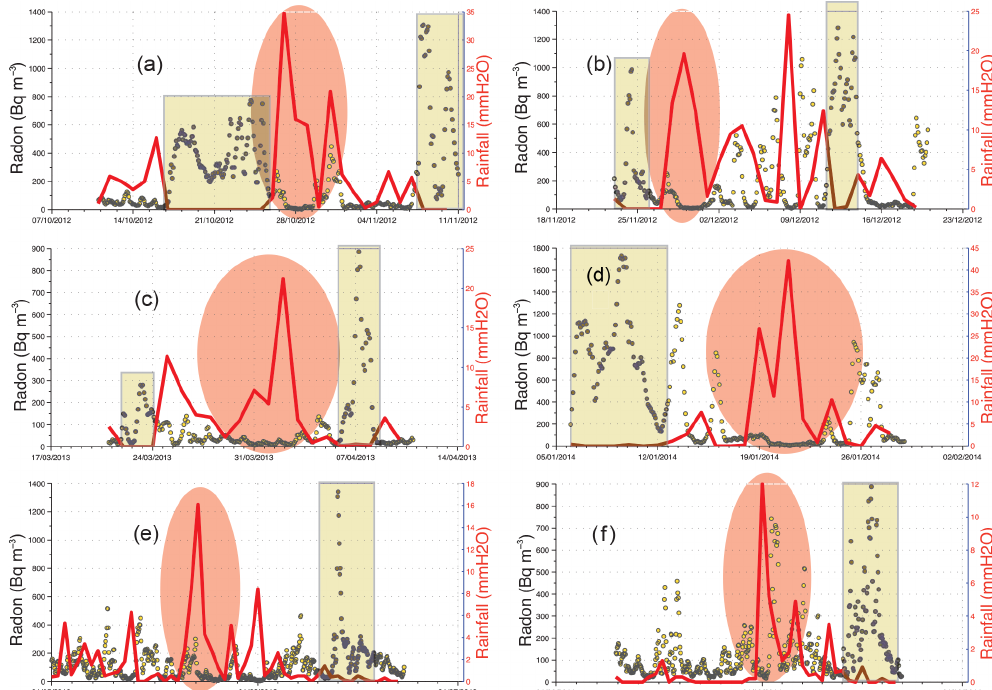
Figure 2. MMN radon concentration in (Bqm − 3 )/115min (yellow dots) and daily average rainfall (red line) for some significant fall–winter (a–d) and spring–summer (e, f) periods (see text for details). Red ellipses mark heavy rain events, whilst yellow rectangles represent radon concentration peaks.